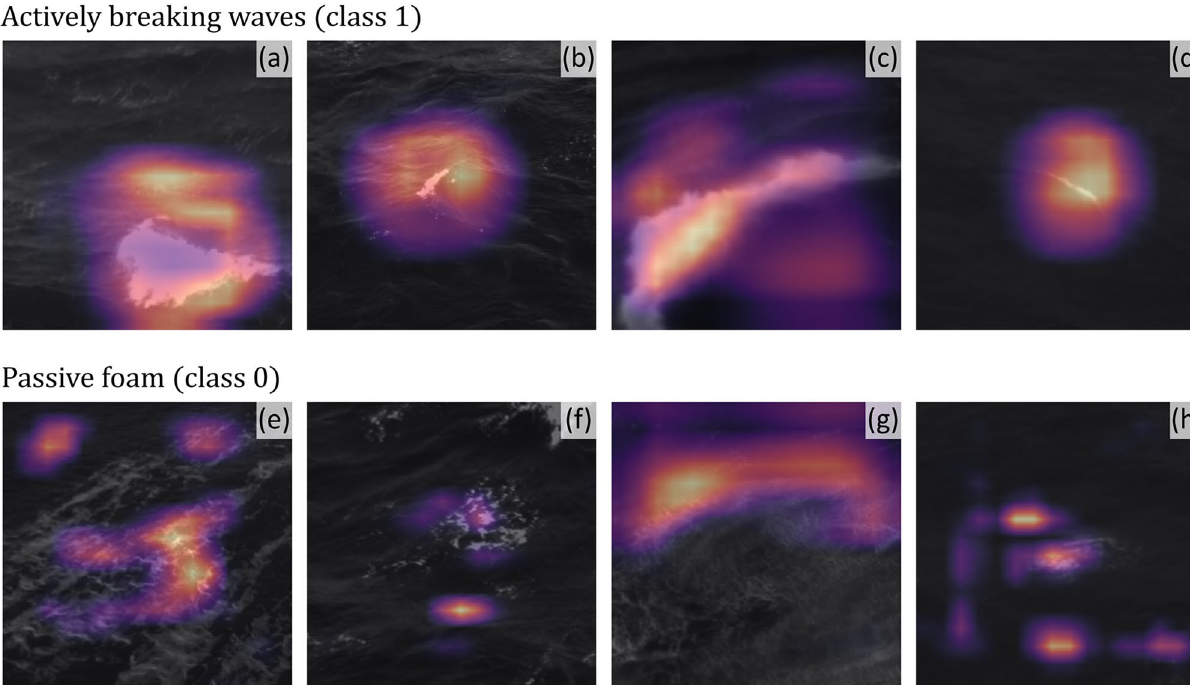
Figure 6. Results of Grad-CAM 59 for all unique experiment locations described in Table 1 applied to actively breaking waves (top row) and to passive foam (bottom row). ( a ) Actively breaking wave example recorded at Adriatic Sea (2015/03/05 10:35). ( b ) Actively breaking wave example recorded at the Black Sea (2011/10/04 11:07). ( c ) Actively breaking wave example recorded at La Jument (2018/01/03 09:39). ( d ) Actively breaking wave example recorded at the Yellow Sea (2017/05/13 05:00). ( e ) Passive foam example recorded at Adriatic Sea (2015/03/05 10:35). ( f ) Passive foam example recorded at the Black Sea (2011/10/04 11:07). ( g ) Passive foam example recorded at La Jument (2018/01/03 09:39). ( h ) Passive foam example recorded at the (2017/05/13 05:00). In all panels, the color scale indicates the weights of the class activation map with brighter colors showing regions of the image which the neural network used to classify each particular